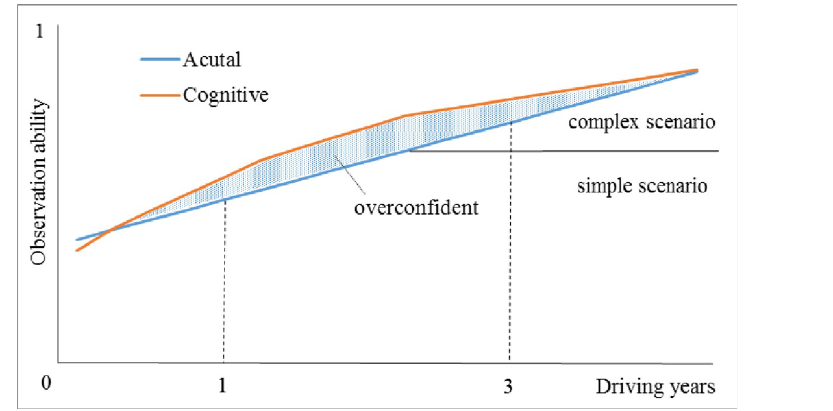
Fig 10. Observation ability change schematic following the rising of driving